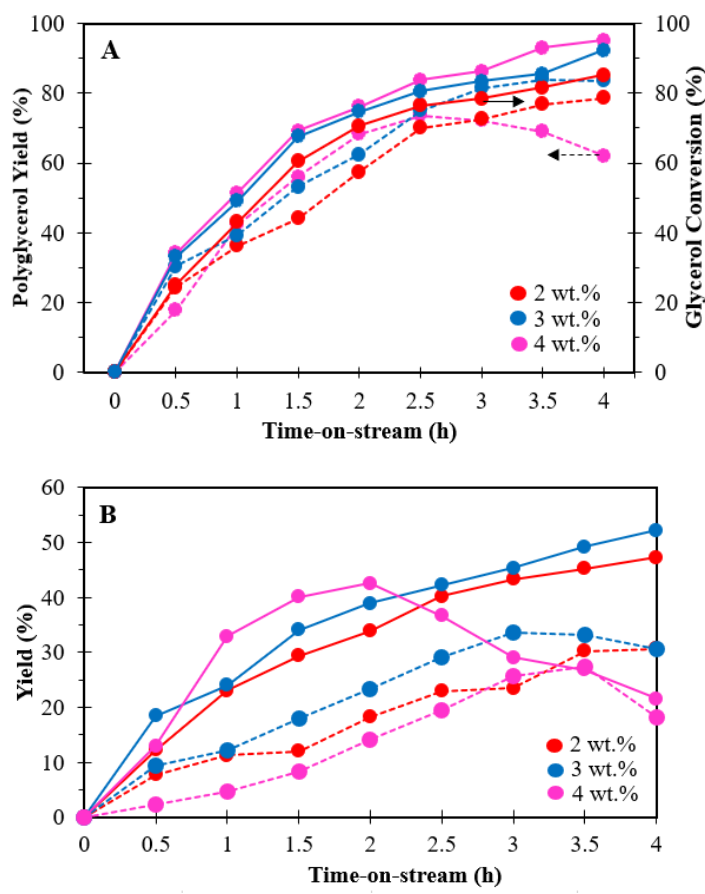
Figure 8. ( A ) Conversion of glycerol to polyglycerol and ( B) short-chain oligomers (solid line: Diglycerol, dotted line: Triglycerol) formation in the presence of di ff erent catalyst wt. % loading at 200 ◦